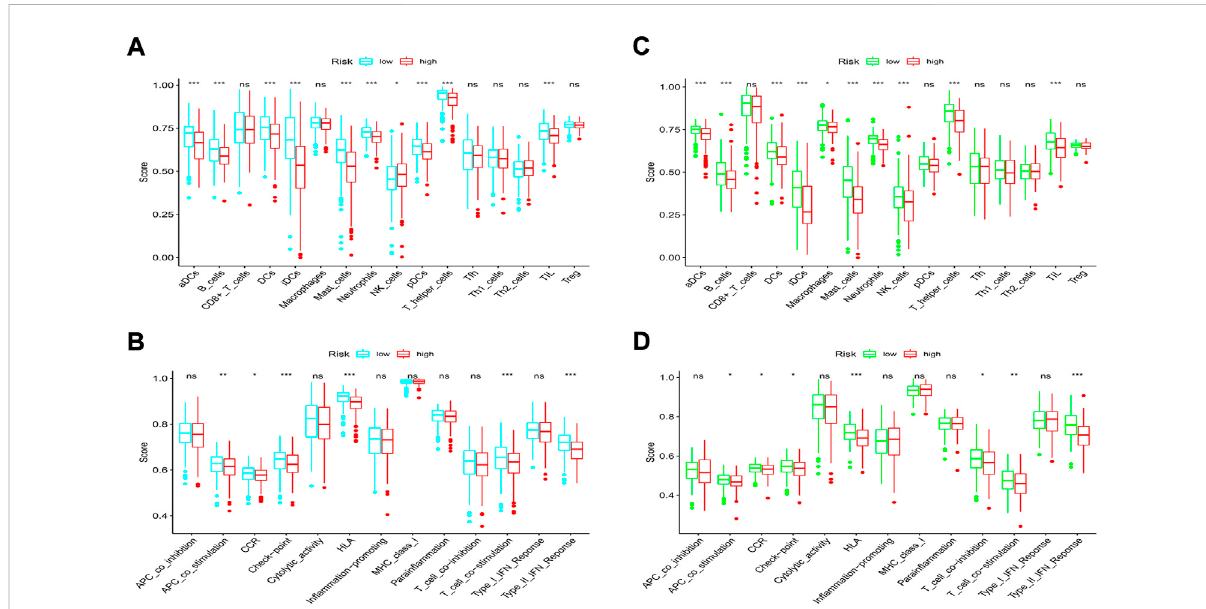
FIGURE 10 Comparison of immune cells and immune pathways. (A,B) Comparison of the enrichment scores of 16 immune cells and 13 immune-related pathwaysbetweenthelow-andhigh-riskgroupsinthetrainingset. (C,D) Comparisonoftheenrichmentscoresof16immunecellsand13immune- related pathways between the low- and high-risk groups in the validation set. (ns, not signi fi cant; * p < 0.05; ** p < 0.01; *** p <